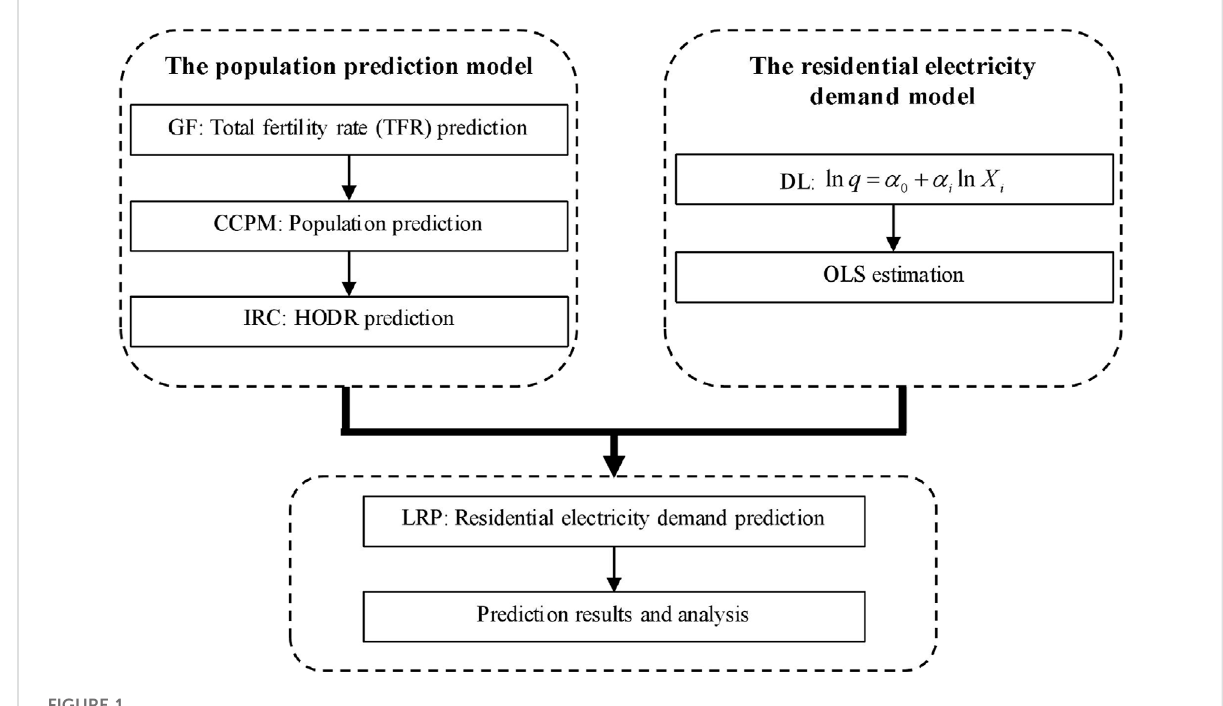
FIGURE 1 Schematic diagram of this